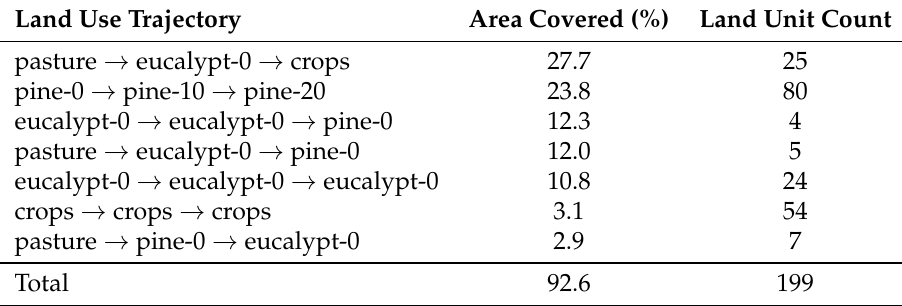
Table 6. Distribution of land use trajectories over the Tabacay catchment that optimizes land performance, obtained by applying BIOLP for the reference scenario (7 out of 27 assigned trajectories are